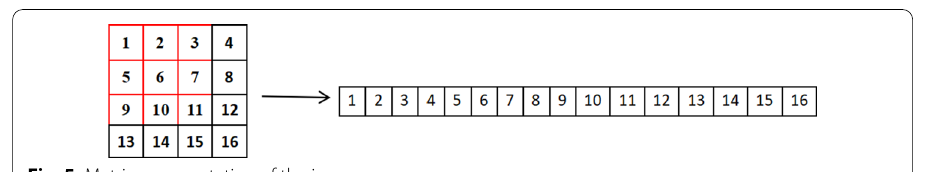
Fig. 5 Matrix representation of the